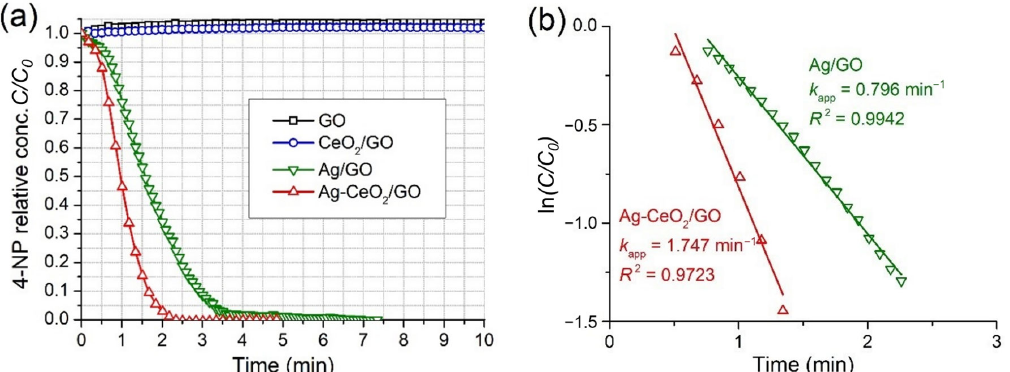
Figure 7. Kinetic curves of 4-NP reduction over the as-prepared samples ( a ) and the pseudo-first-order plot of the 4-NP relative concentration logarithm ln( C / C 0 ) versus the reaction time for the Ag/GO and Ag-CeO 2 /GO catalysts ( b ). Experimental conditions: C (4-NP) = 7.5 × 10 − 5 M, C (NaBH 4 ) = 0.015 M, C (catalyst) = 0.03 g/L, T = 297 K.